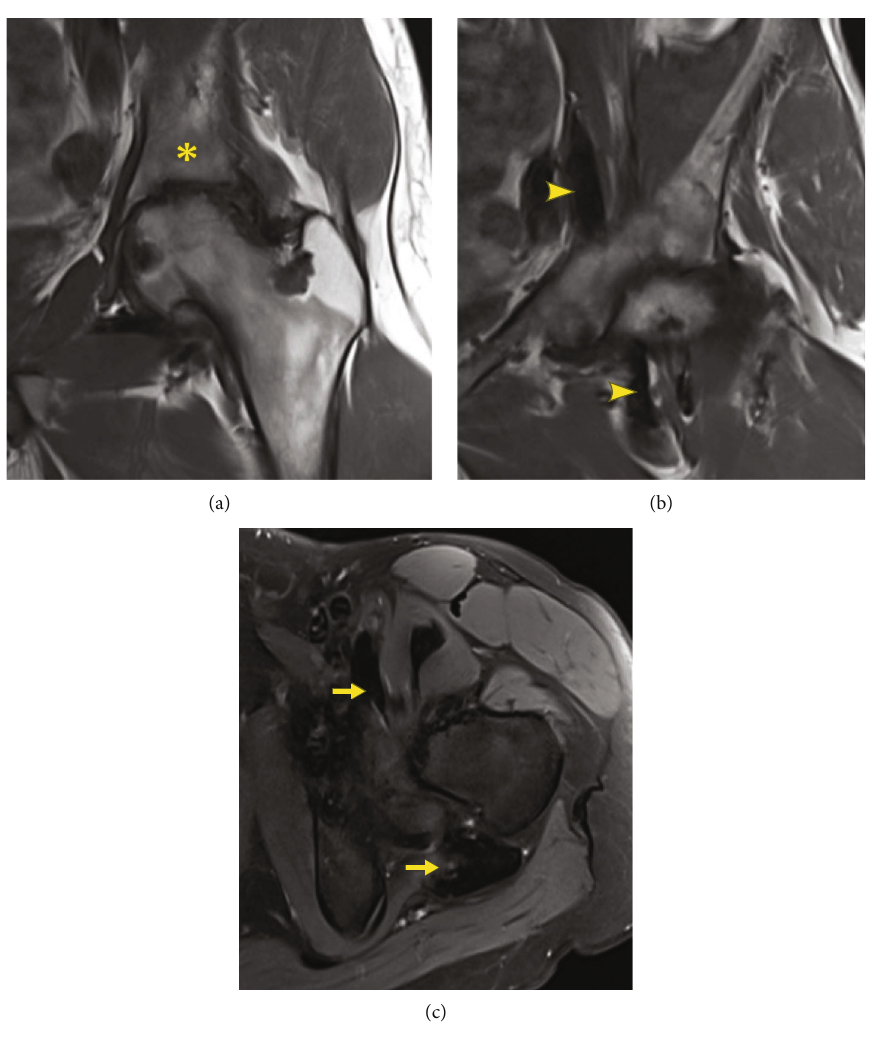
Figure 3: Representative MRI slices of a 29-year-old male with D-TGCT in the hip 12 months after the initiation of pexidartinib. Post- pexidartinib treatment coronal (a, b) and axial (c) MR imaging demonstrates persistent end stage hip arthritis ( ∗ ) but signi fi cant reduction in TGCT tumor burden tracking along the anterior hip into the pelvis (arrowhead) as well as signi fi cant reduction of both the ischiofemoral and anterior psoas tumor burden (arrow).